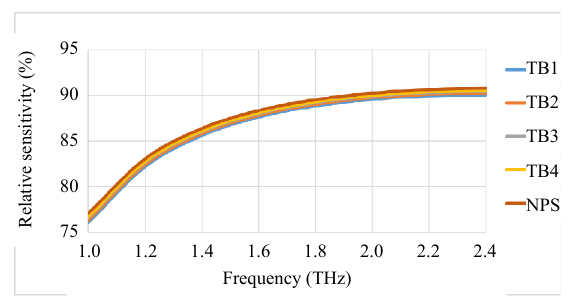
Fig. 6 RS of the proposed sensor for various samples infected with tuberculosis versus frequency.